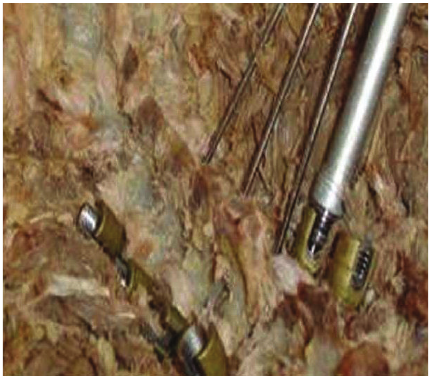
Figure 6: Pedicle screws after forced insertion with 15-degree angle.